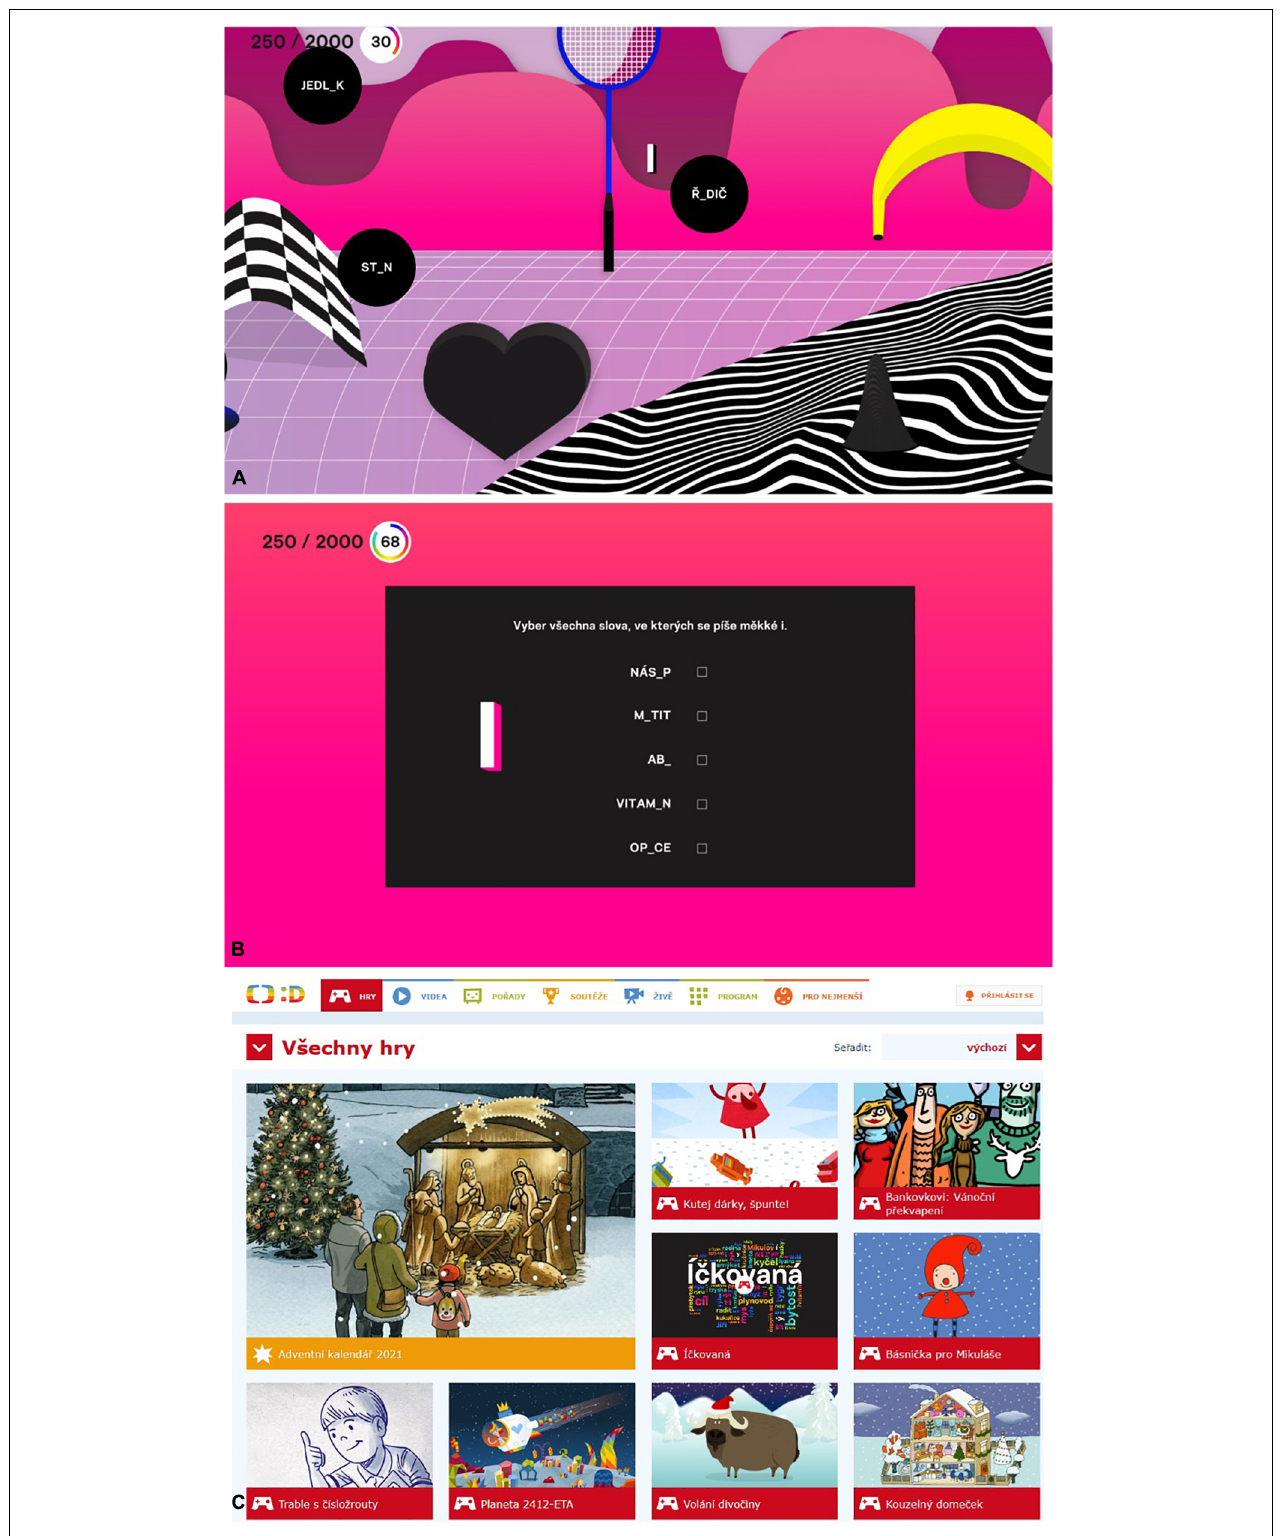
FIGURE 1 | Demonstration of (A) the gameplay in the experimental intervention, (B) the control intervention and (C) the ˇCT Déˇcko website with the same banner for the Íˇckovaná experimental and the control interventions (placed in the middle). [Courtesy of Czech Television (c)].